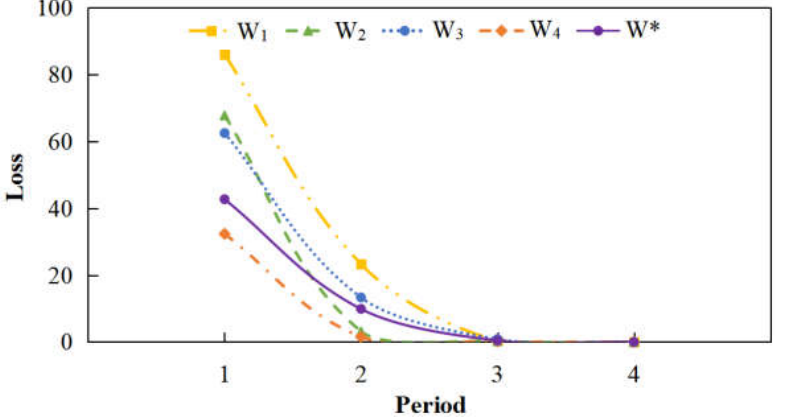
Figure 5. Loss due to shortages of emergency materials in each time period under different decision criteria.